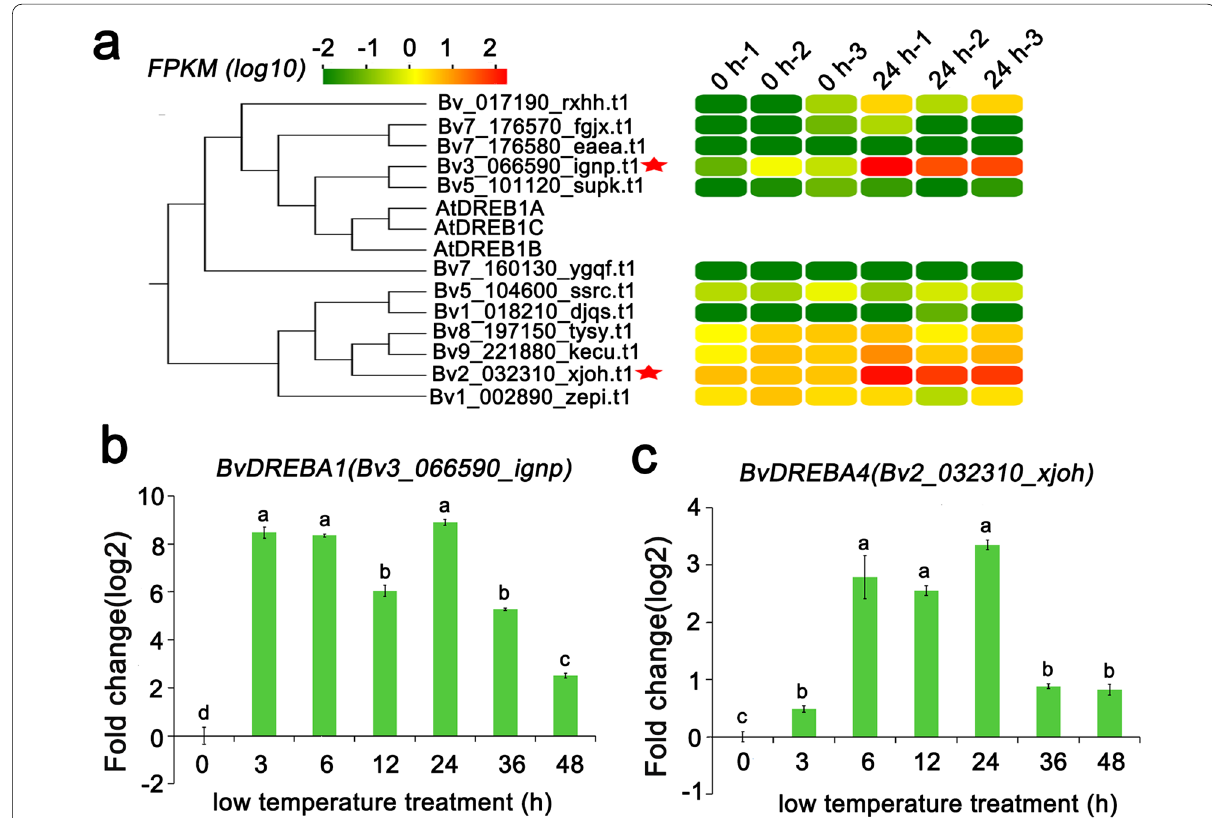
Fig. 3 The patterns of expression of BvDREBA1 and BvDREBA4 . a Transcriptome analysis of gene expression of BvDREBA1 and BvDREBA4 at low temperature (4 °C). b The pattern of expression of BvDREBA1 in response to low temperature (4 °C). c The pattern of expression of BvDREBA4 in response to low temperature (4 °C). Different letters represent significant levels of P < 0.05 between different low temperature